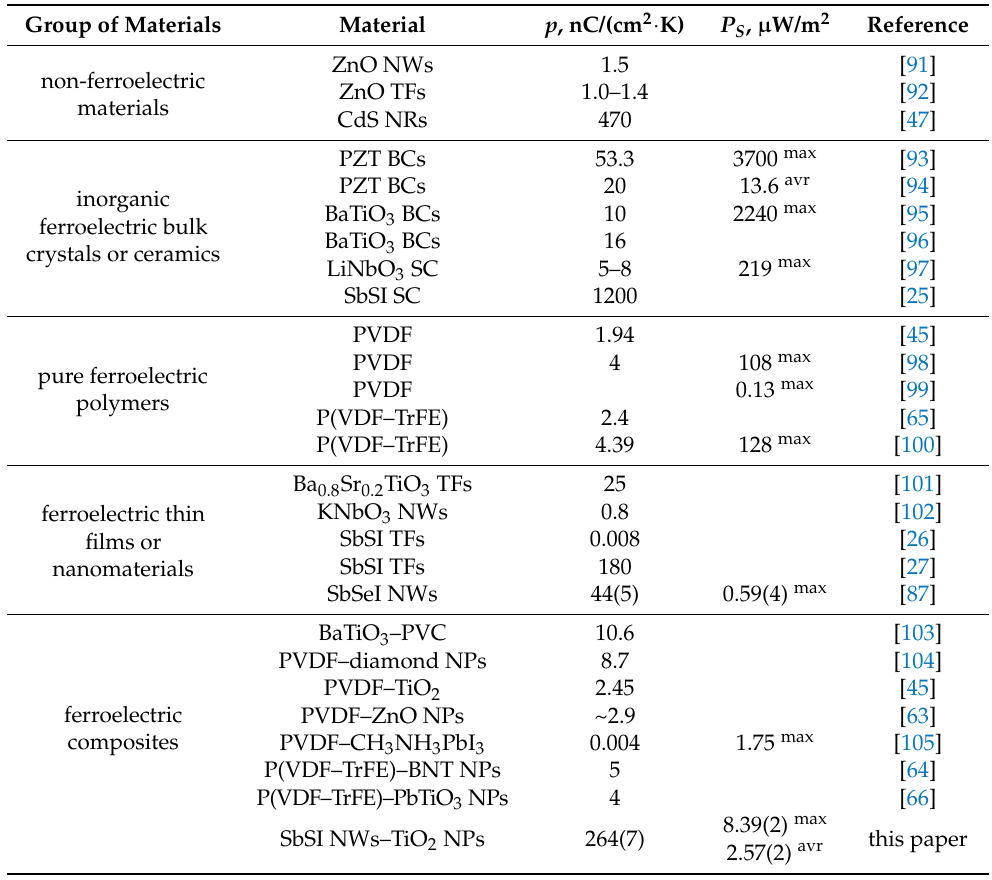
Table 3. Comparison of the pyroelectric performance achieved for the SbSI–TiO 2 nanocomposite and other materials (BCs—bulk ceramics; BNT—Bi 0.5 Na 0.5 TiO 3 ; NPs—nanoparticles;